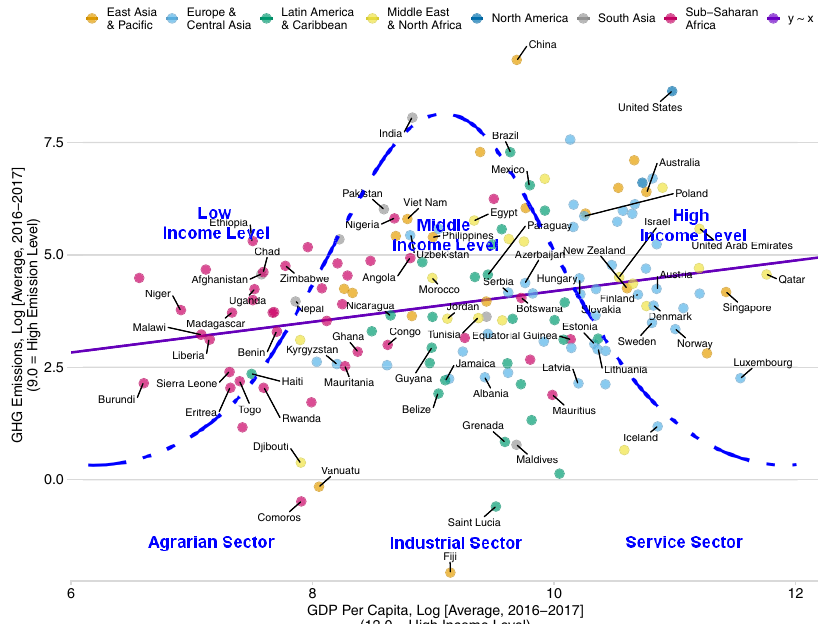
Fig. 7 Nexus between anthropogenic GHG emissions and income level across income groups. Using average data spanning 2016 – 2017 helps to account for the inception and impact of the SDGs, speci fi cally the 13 th target of climate change mitigation. This plot captures regional convergence (i.e., East Asia & Paci fi c, Europe & Central Asia, Latin America & Caribbean, Middle East & North Africa, North America, South Asia, and Sub-Saharan Africa) of sampled economies.